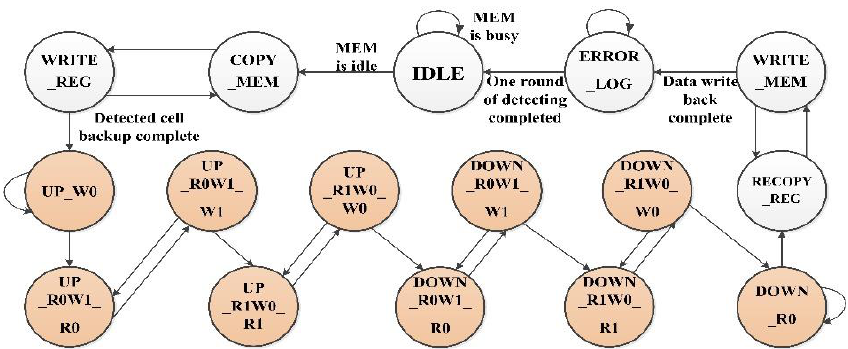
Figure 5. The finite state machine for Memory Detection Module (MDM).